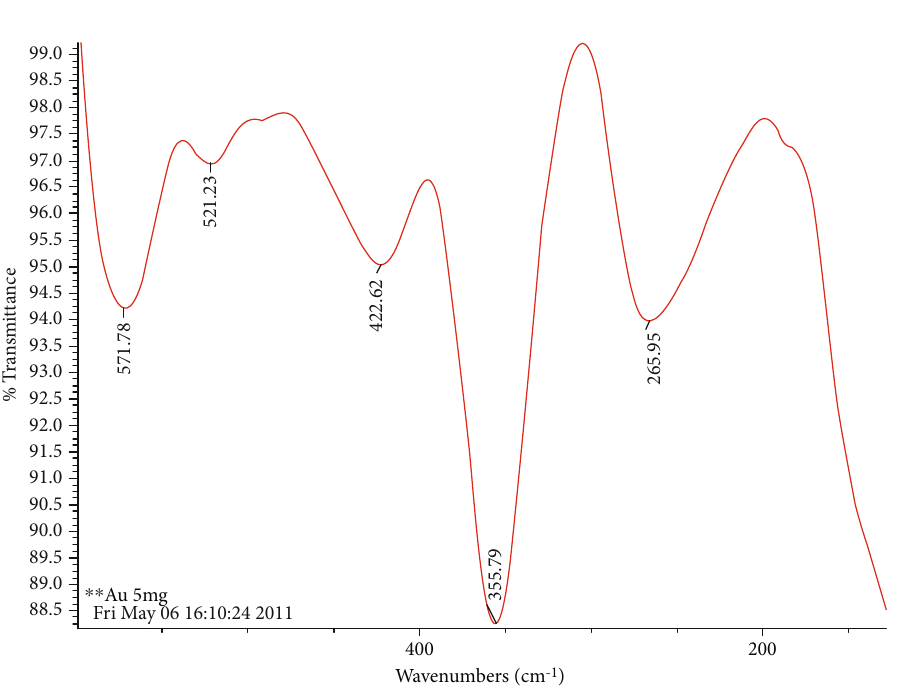
Figure 9: Far infrared spectrum for gold quantum dots (Au [A]-Qs) supported in